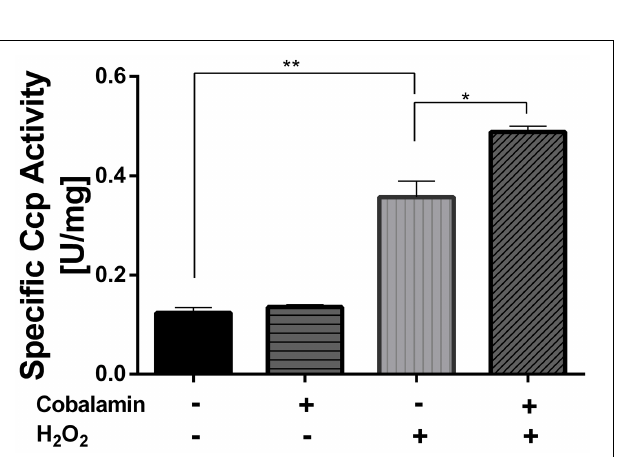
FIGURE 3 | Effect of cobalamin on thioredoxin and thioredoxin reductase activity. To measure Trx activity (A) , the reduction of the alpha-chain of insulin was monitored at 650 nm as described under Section “Materials and Methods.” TR activity (B) was monitored by following the reduction of 5,5 (cid:48) -dithiobis-(2-nitrobenzoic acid) (DTNB) at 412 nm. The activity in the control reaction corresponds to 100%. Data represent the average of two independent experiments (lines on top of bars indicate value ranges). ∗ P < 0.05, ∗∗ P < 0.01.